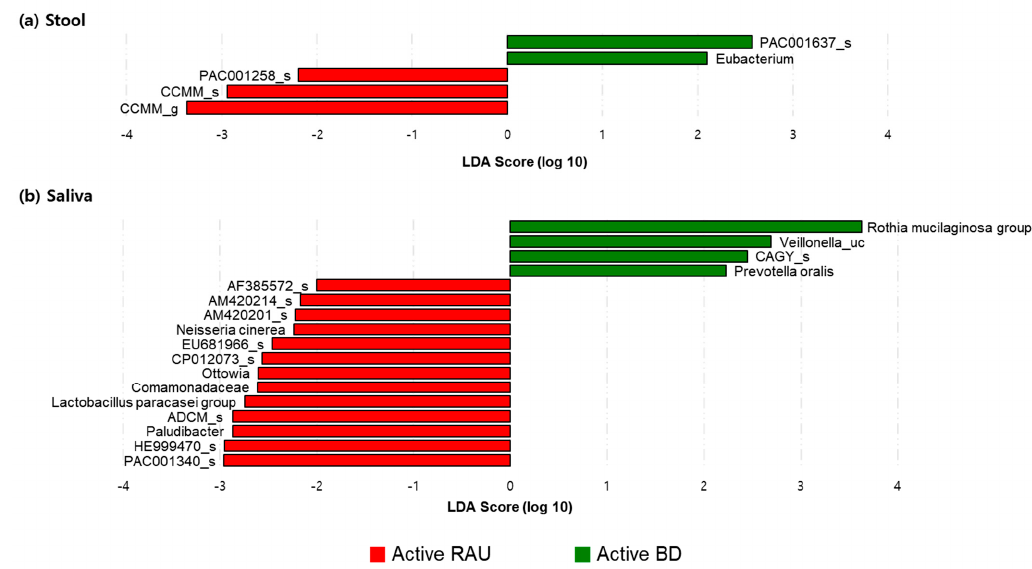
Figure 5. Relative abundances of taxa in the microbiomes of stool ( a ) and saliva ( b ) in active BD (green) and active RAU (red) groups. The linear discriminant analysis (LDA) scores (log 10) were calculated using the LDA Effect Size (LEfSe) algorithm. Salivary Rothia mucilaginosa was significantly higher in active BD than in active RAU ( p = 0.01), although the taxon with an LDA score (log 10) of more than 4 was not detected in the fecal and salivary samples.